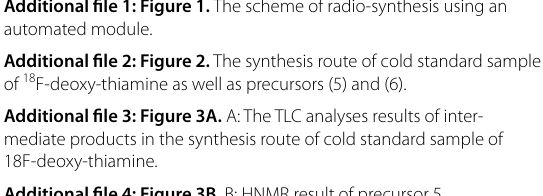
Additional file 4: Figure 3B. B: HNMR result of precursor